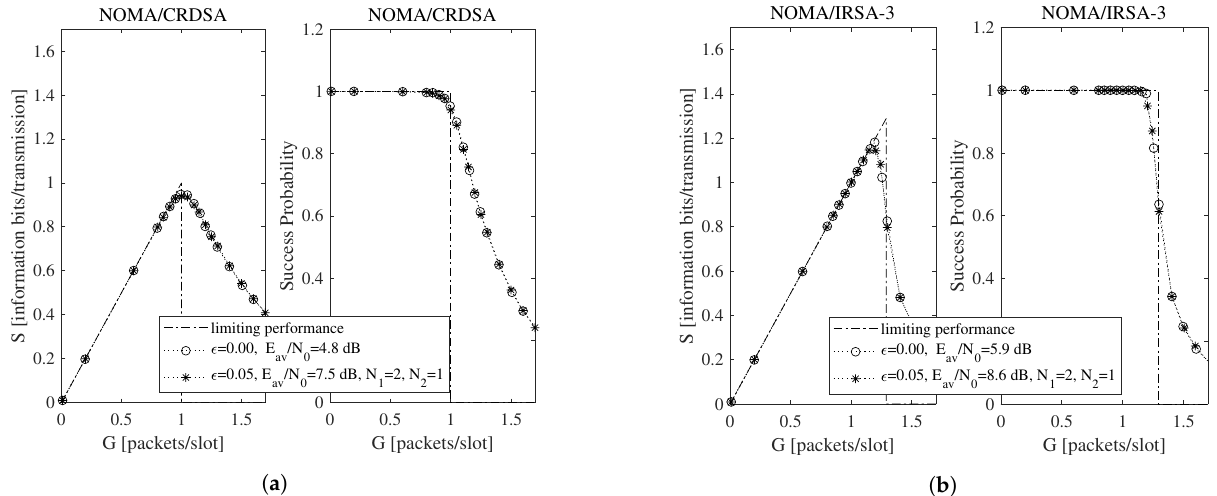
Figure 5. Throughput and success probability as a function of the channel load for K = 1000, L = 2, and R = 1 information bits per symbol: ( a ) NOMA/CRDSA, ( b )